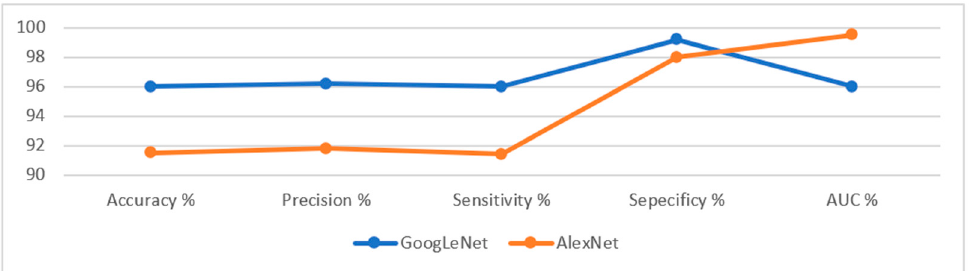
Figure 18. Display results of the GoogLeNet and AlexNet models for diagnosing a low GI dataset.